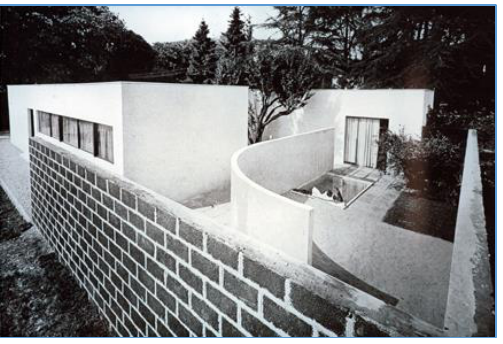
Figure 6. Villa studio for an artist